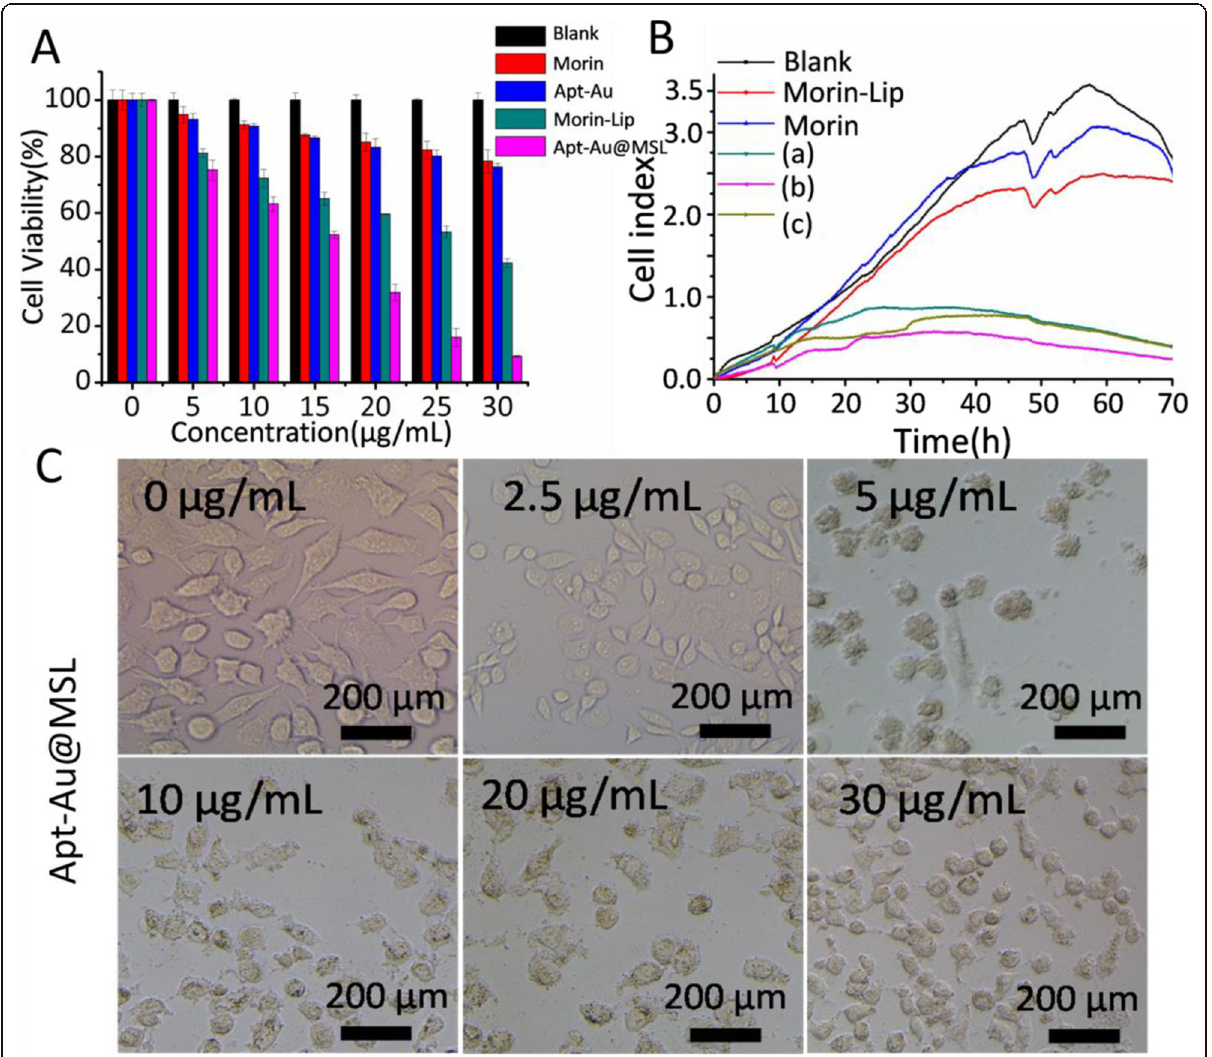
Fig. 4 a Cell viability of SGC-7901 cells incubated with different material (Morin, Au-Apt, Morin – liposome, and Apt-Au@MSL) at different concentrations (0, 5, 10, 15, 20, and 30 μ g/mL). The cell has treated by PBS was set as blank group. b The cell proliferation curve of SGC-7901 cells was detected by RT-CES system. The different compounds were added at 10 h. The concentrations of a , b , and c are different Apt-Au@MSL (10, 20, and 30 μ g/mL), respectively. c The bright cell images at the different concentrations (0, 2.5, 5, 10, 20, and 30 μ g/mL)